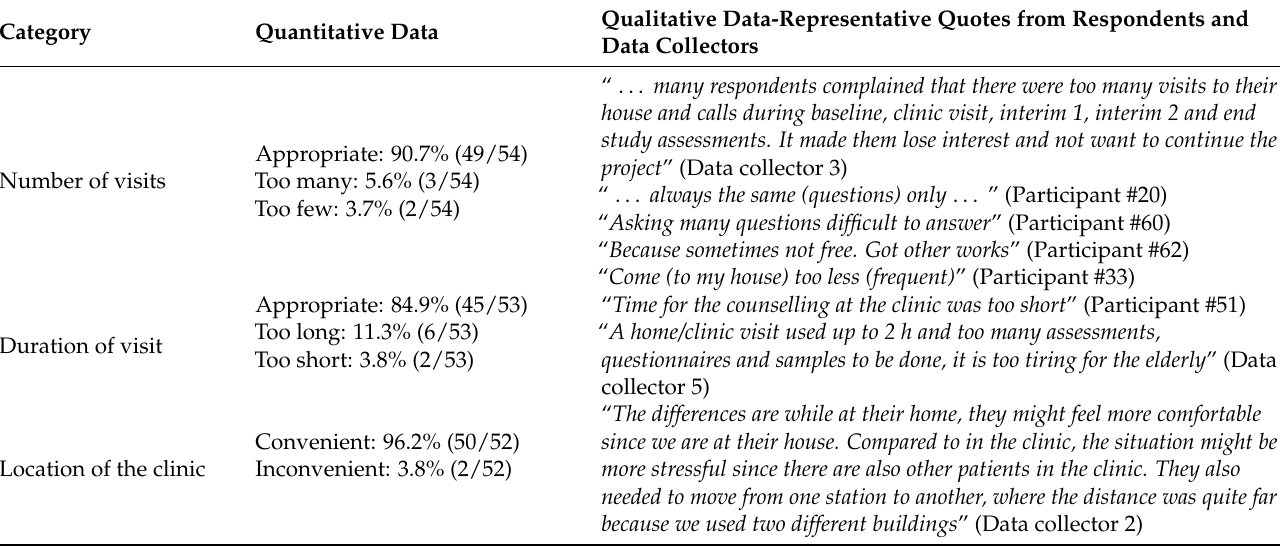
Table 2. The quantitative and qualitative results regarding the acceptability of screening and